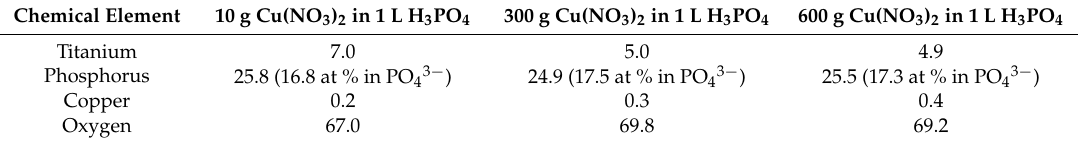
Table 4. Chemical composition of PEO layers, at %.